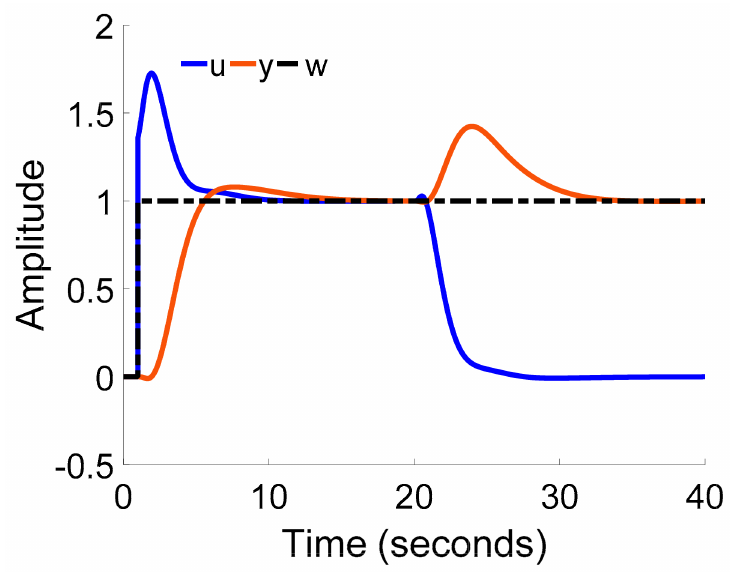
Figure 24. PID control of process (18).